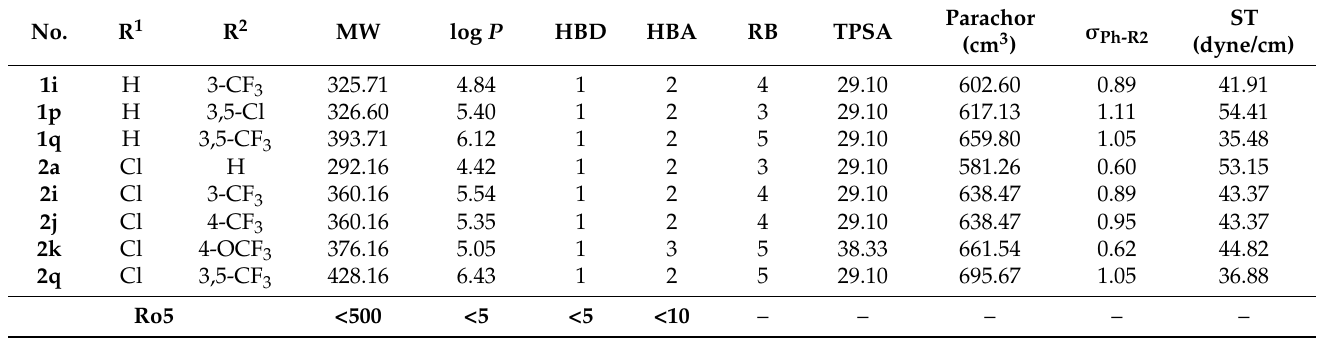
Table 3. Values of parameters characterizing physicochemical properties calculated using ACD/ Percepta ver. 2012 in relation to Lipinski’s Rule of Five